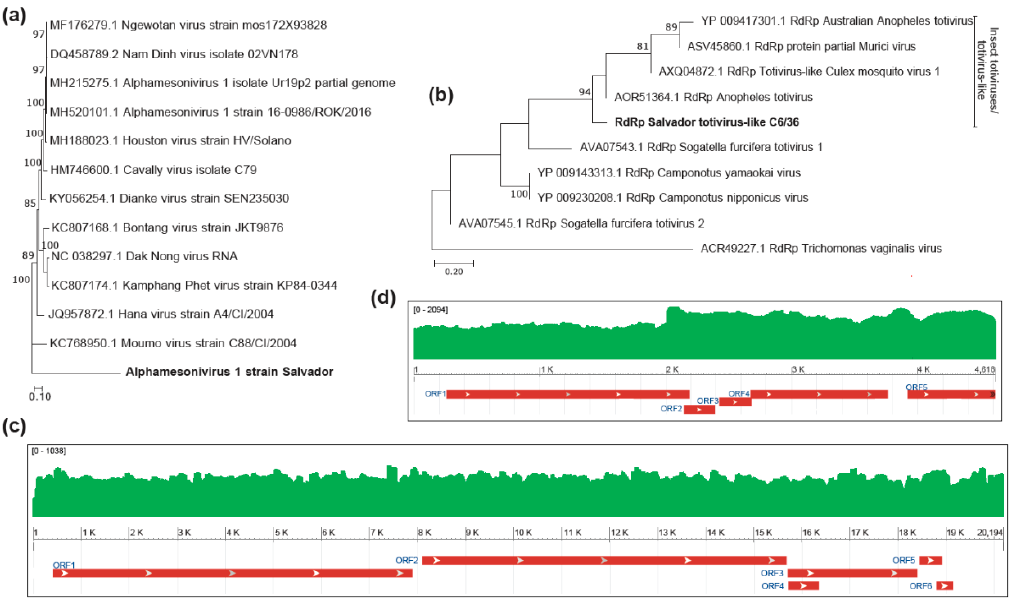
Figure 3. Characterization of viruses identified in the A. albopictus C6/36 cell line. Maximum likelihood phylogenetic trees of the (a) new strain of Alphamensonivirus and (b) new viral specie related to the Totiviridae family. RNA coverage of identified viral genomes are shown for (c) Alphamensonivirus and ( d ) Totivirus-like .